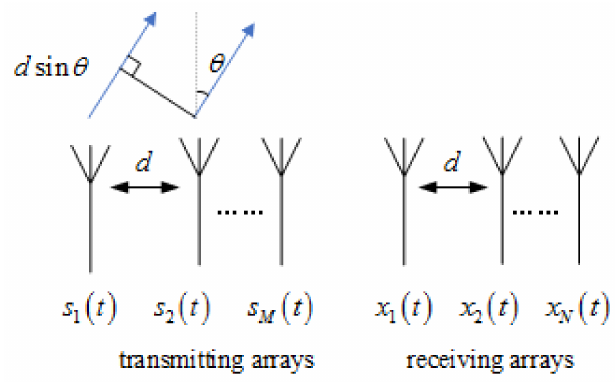
Figure 2. Schematic diagram of MIMO radar target